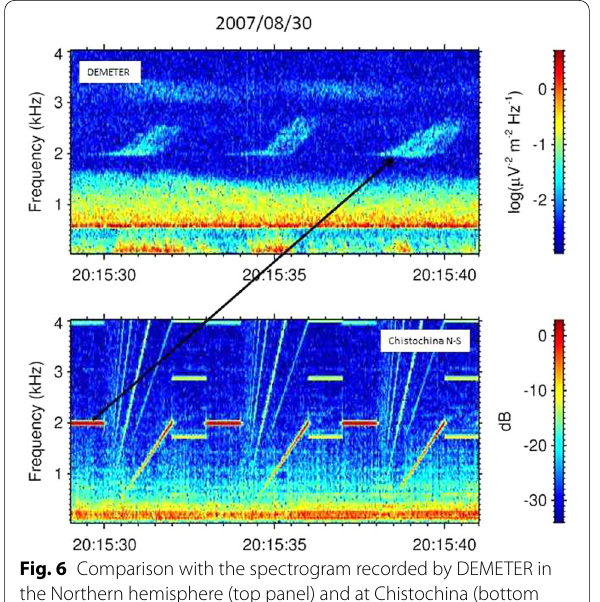
Fig. 6 Comparison with the spectrogram recorded by DEMETER in the Northern hemisphere (top panel) and at Chistochina (bottom panel). The power spectral density is color-coded according to the scale on the right. The black arrow indicates the correspondence between a pulse seen at Chistochina and the same pulse with triggered emissions observed by DEMETER